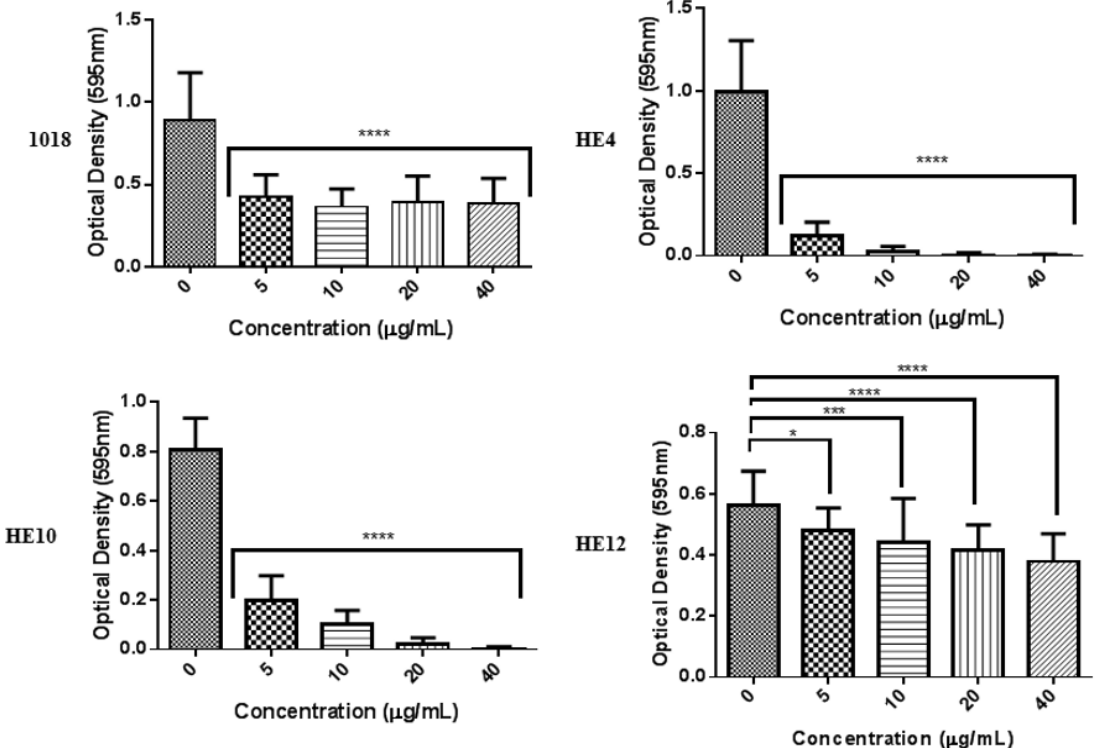
Figure 3. Biofilm inhibitory activity against methicillin resistant Staphylococcus aureus (MRSA) in 96-well plates. Dilutions (1/100) of overnight cultures were incubated in